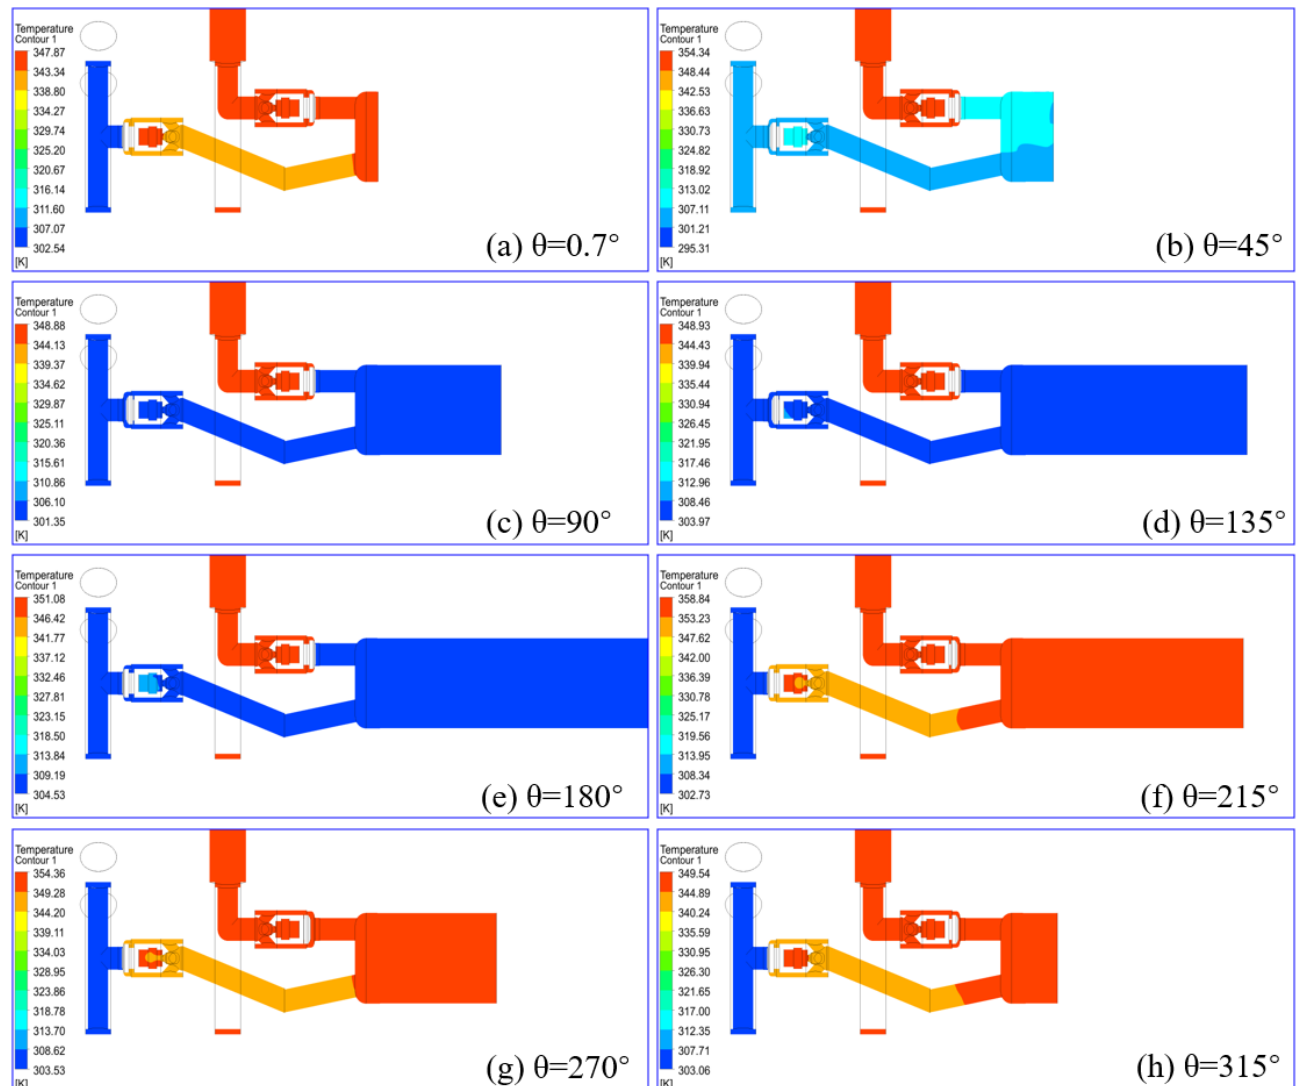
Figure 9. Temperature distribution and evolution during the working process of the hyper com- pressor.